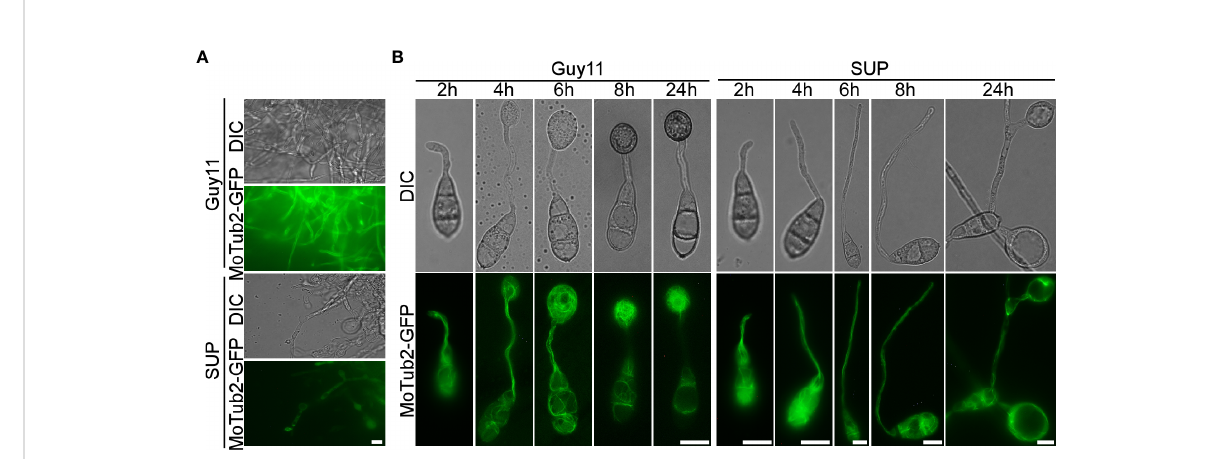
FIGURE 5 KC81 SUP impairs microtubule cytoskeleton organization of M. oryzae . (A) Live cell imaging experiment to show MoTub2-GFP localization in M. oryzae mycelium in the presence or absence of KC81 SUP. (B) Live cell imaging experiment to show MoTub2-GFP localization during M. oryzae appressorium development in the presence or absence of KC81 SUP. Bar = 10 m